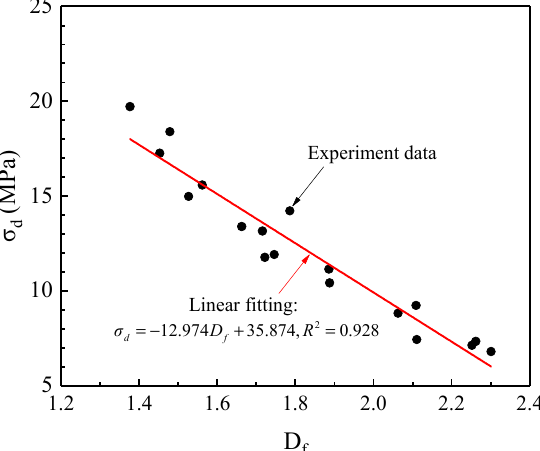
Figure 21. Relation between dynamic strength and fractal dimension following fragmentation. Constant strain rate is used, while samples have different PSDs––based on Table 2. Figure 22 shows the effect of strain rate on the relation between dynamic strength and the fractal dimension for samples with different Talbot indices; the experimental data (Table 3) show that the dynamic strength increases with increasing fractal dimension for sample sets with different Talbot indices (as shown in Figure 22a–c). When the PSD remains unchanged and only the strain rate is changed, the fractal dimension is positively correlated with the dynamic strength, as seen through linear fitting. This phenomenon indicates that for the same values of the PSD, the strain rate directly determines the dynamic strength and fractal characteristics of the cemented rock sample, with both exhibiting the same response characteristics as the strain rate effect. Therefore, a positive linear correlation exists between dynamic strength and fractal dimension.